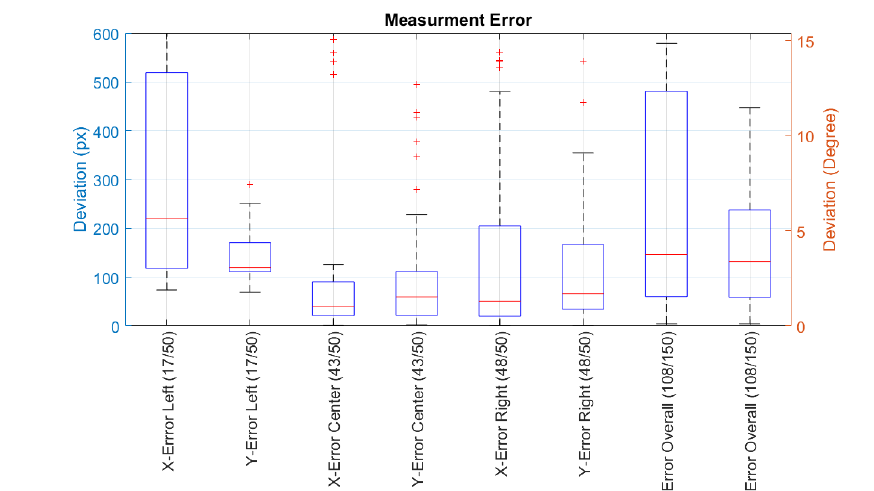
Figure 11: This figure shows boxplots for the mean measurement error caused by the eye tracking setup. It is divided into screen- by-screen error and overall error. Included in brackets are the number of datasets which produced usable data in the calibration test vs. the total number of